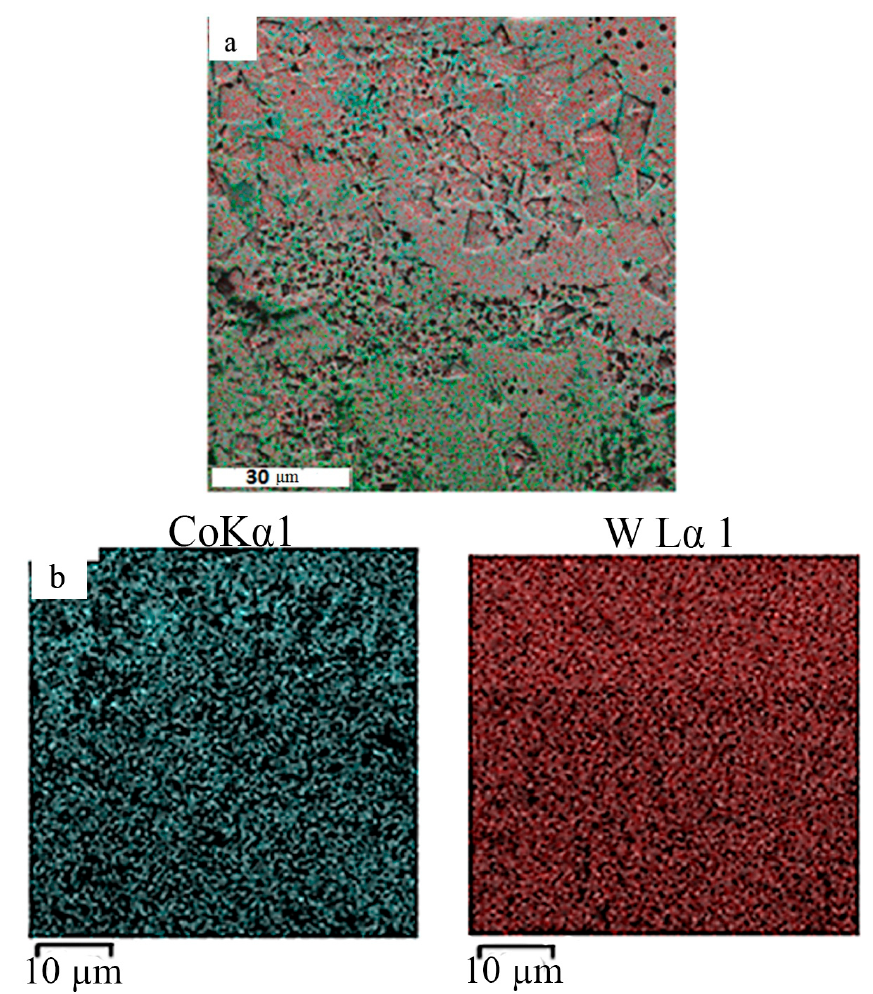
Figure 11. Distribution of chemical elements in a cube sample 94 wt% WC and 6 wt% Co; ( a ) total distribution, ( b ) distribution of individual elements, where the left figure is the distribution of cobalt (blue—cobalt) and the right figure is the distribution of tungsten (red—tungsten).